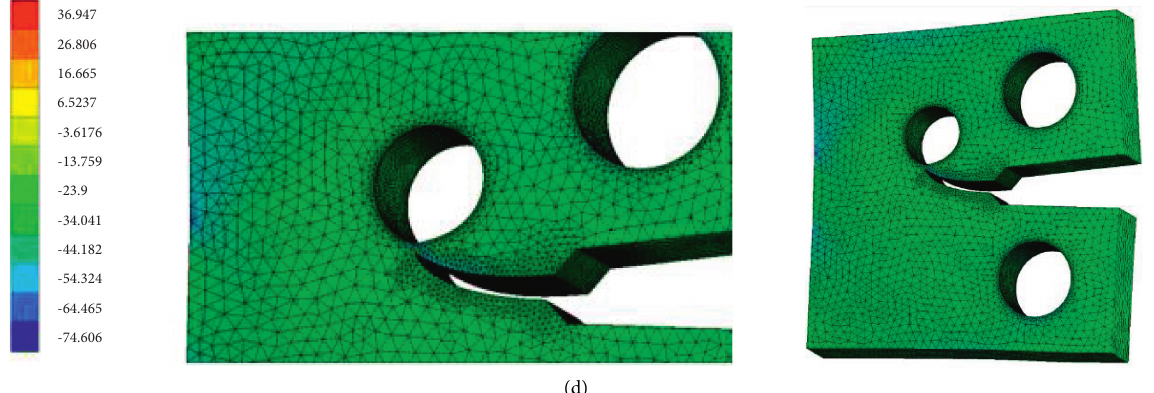
Figure 12: For CT04 specimen, (a) FRANC2D/L, maximum principal stress, (b) ANSYS, maximum principal stress, (c) FRANC2D/L, minimum principal stress, and (d) ANSYS, minimum principal stress.